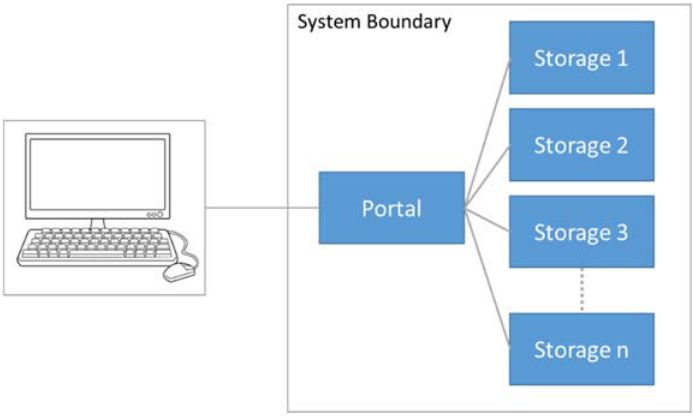
Figure 1. The LACO-Wiki system architecture. The client/user accesses the LACO-Wiki portal, which can make use of multiple storage servers to distribute the data and the processing tasks.